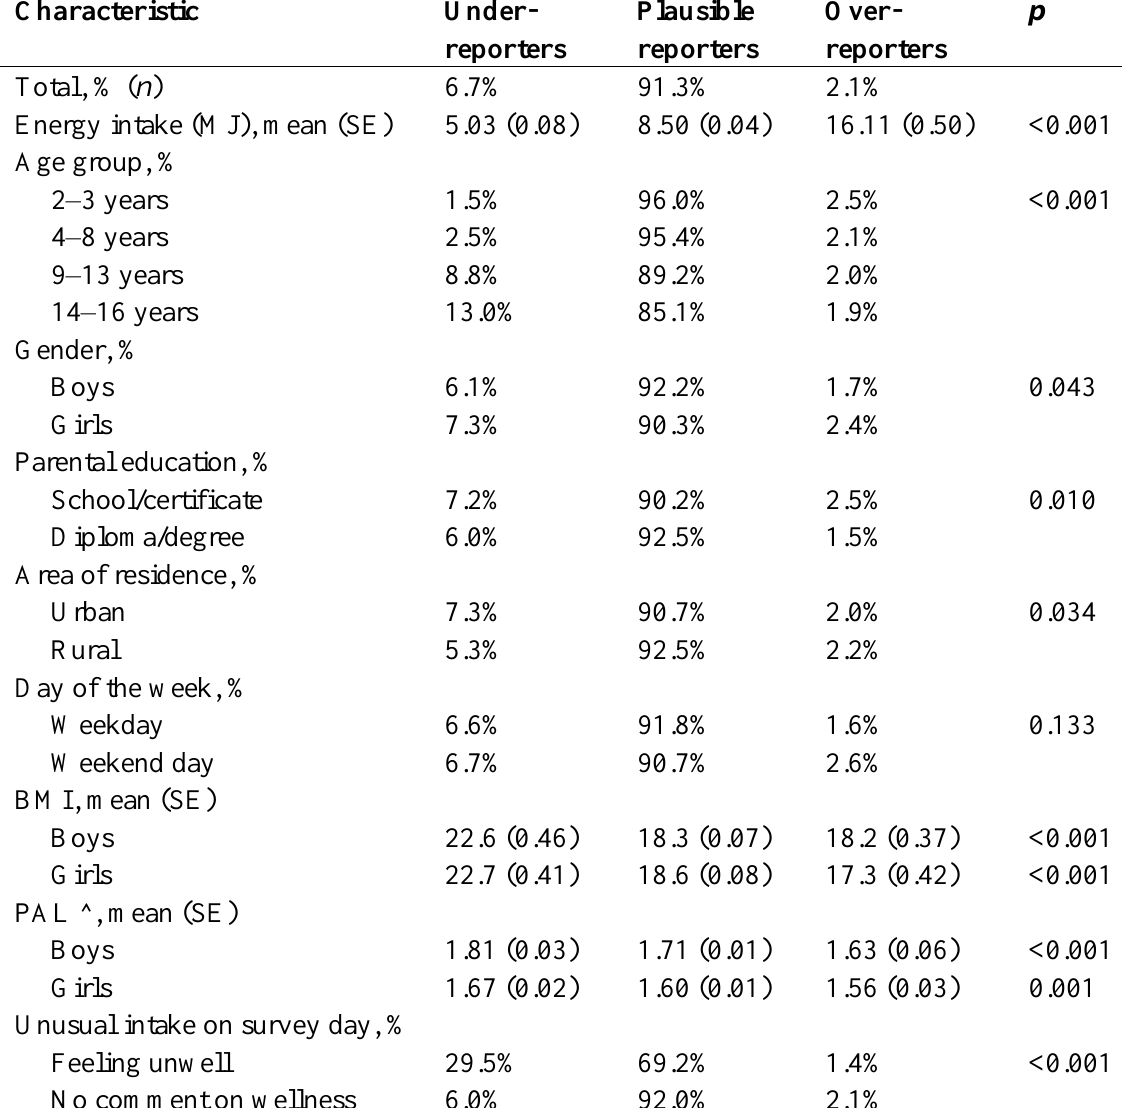
Table 3. Characteristics of misreporters * (identified based on option